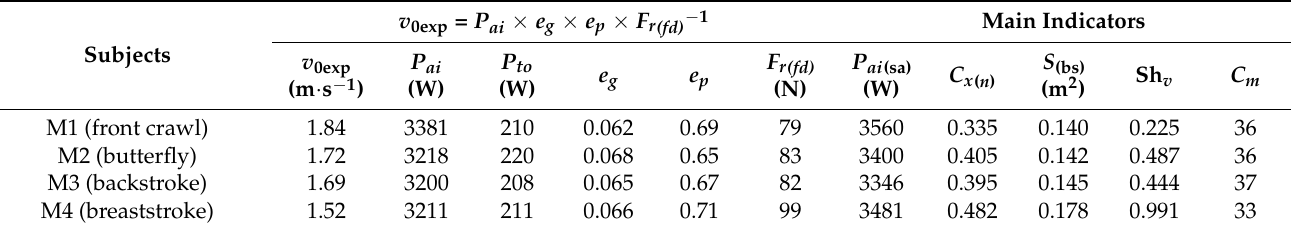
Table 3. Numerical values of parameters of the mathematical model 1 and the main indicators for the male subjects in the last stage of the